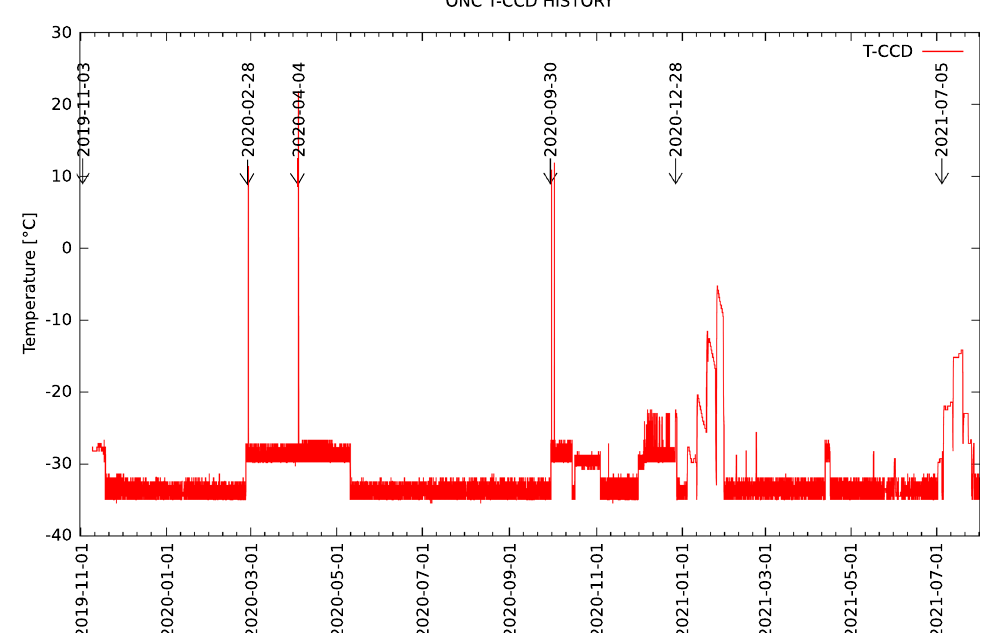
Fig. 5 History of the CCD sensor temperature for ONC-T from November 2019 to July